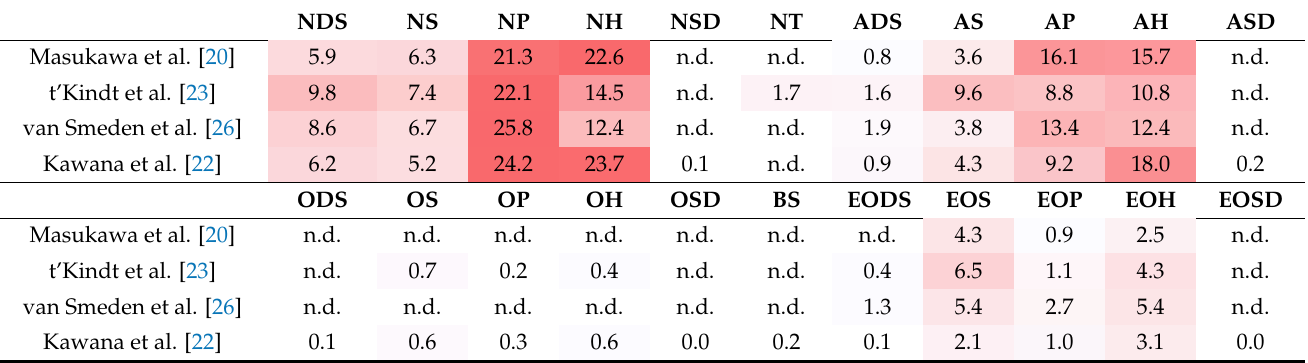
Table 1. The composition of unbound intercellular ceramides in human